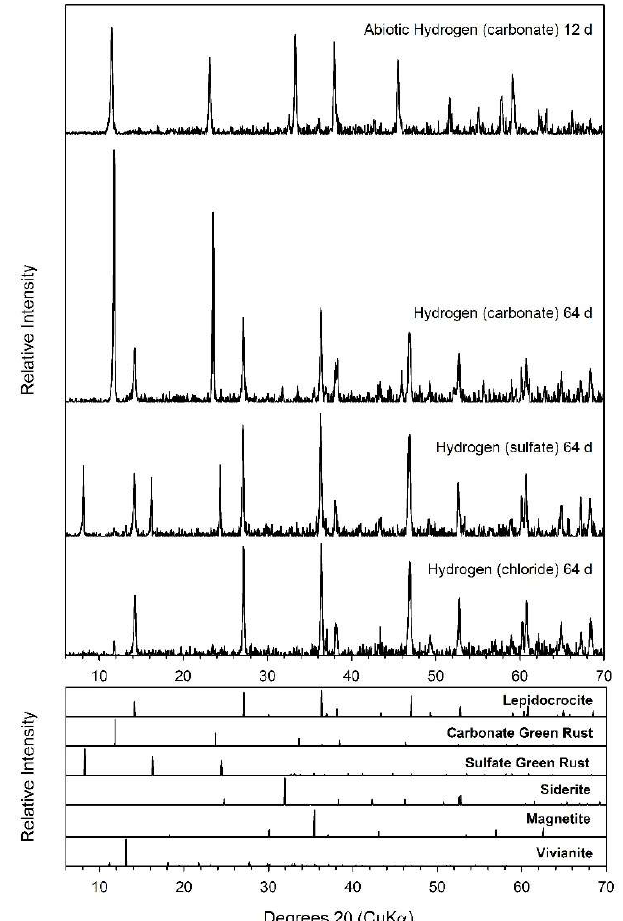
Figure 3. Powder X-ray diffraction analysis of the solids in the H 2 -amended systems at the end of the incubations.